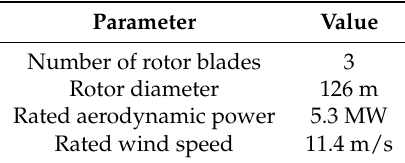
Table 1. Overview of NREL-5MW turbine